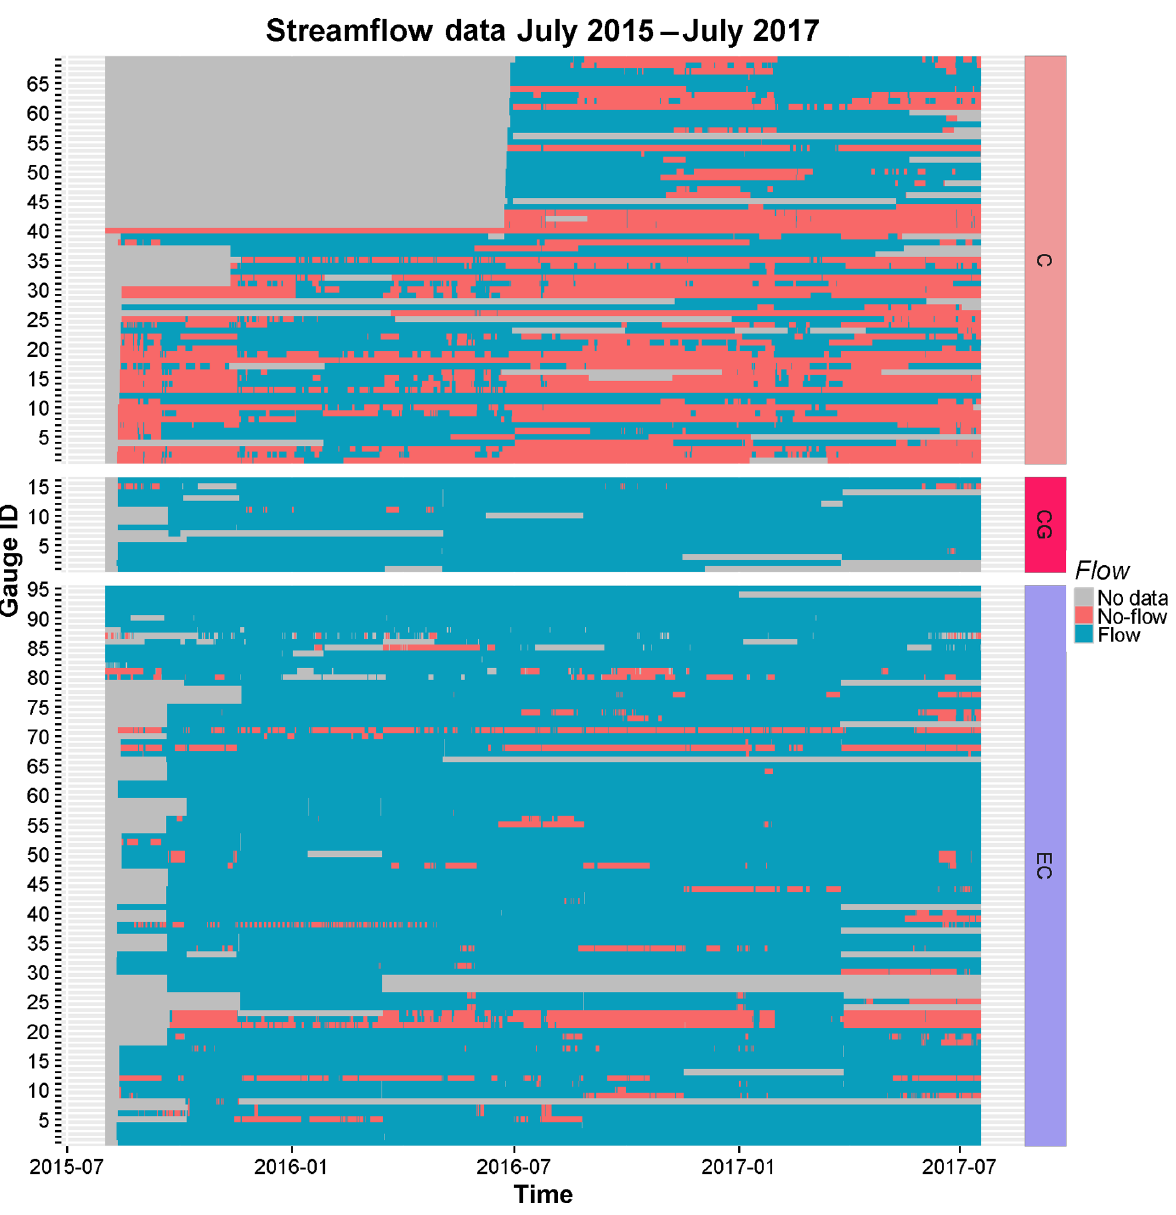
Figure 7. Streamflow data from July 2015 to July 2017. Gauge IDs consist of the abbreviations “C” for time-lapse cameras, “EC” for EC sensors and “CG” for conventional gauges on the right and the corresponding number of the gauge ID on the left. Data are ordered by gauge ID for each sensor